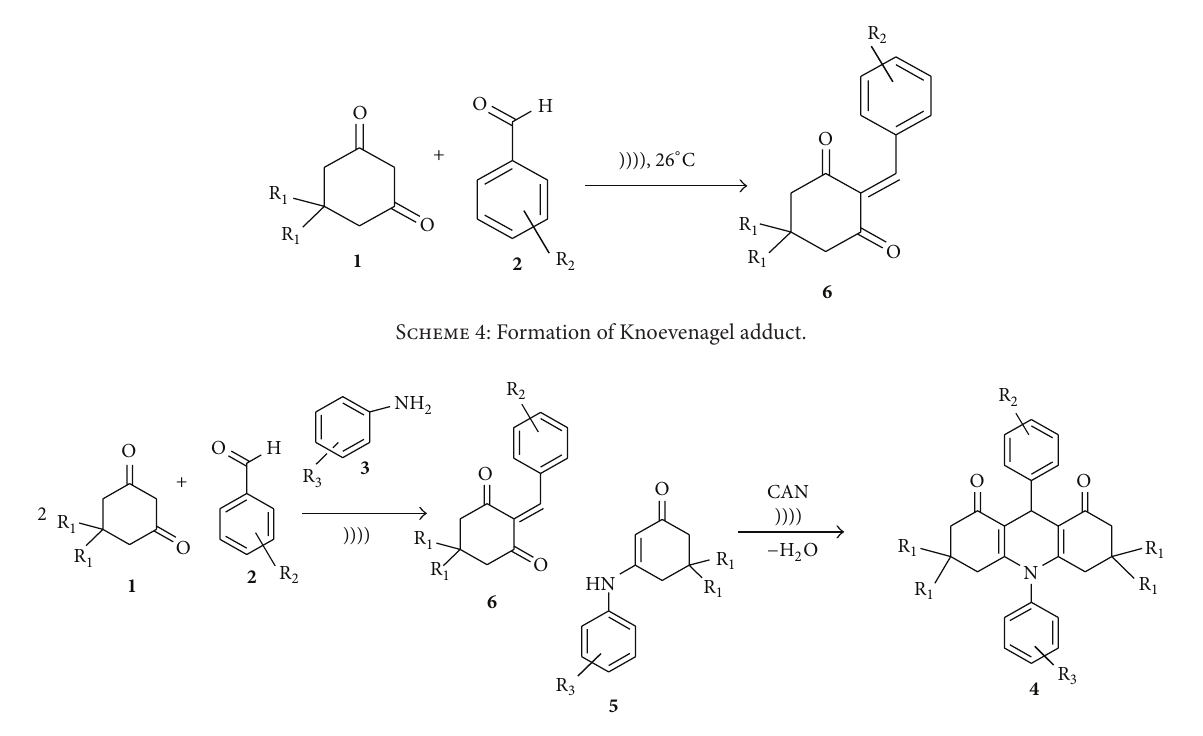
Scheme 5: Formation of N -substituted